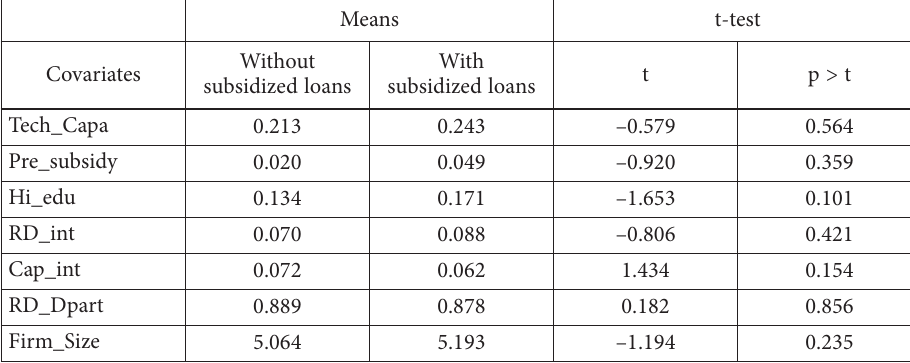
Table A.2. Significance T-test for non-recipients and recipients of subsidized loans